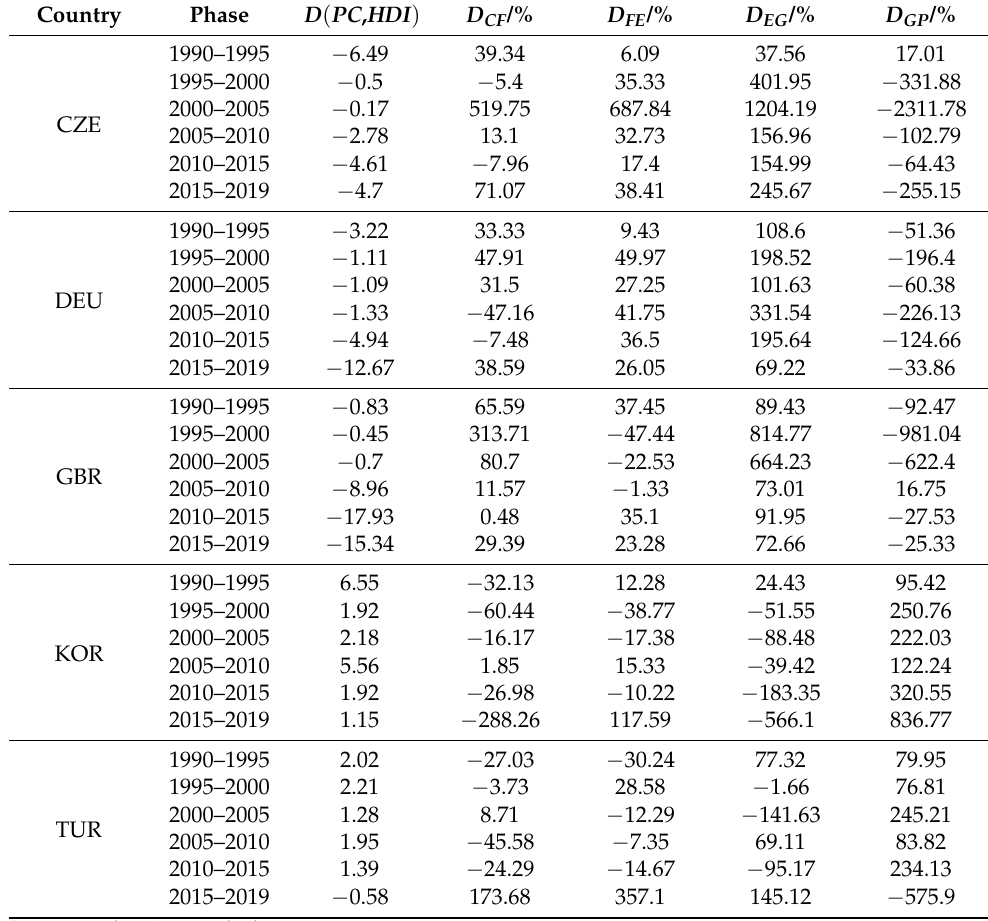
Table 2. Decomposition of the decoupling index for the example